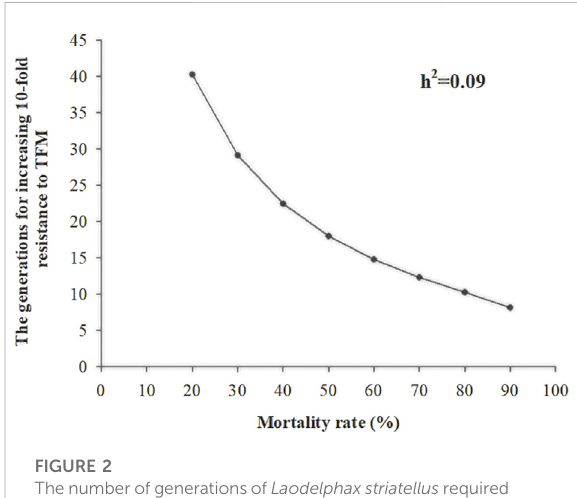
FIGURE 2 The number of generationsof Laodelphax striatellus required for 10-fold in LC 50 of tri fl umezopyrim ( h 2 = 0.09) at different selection